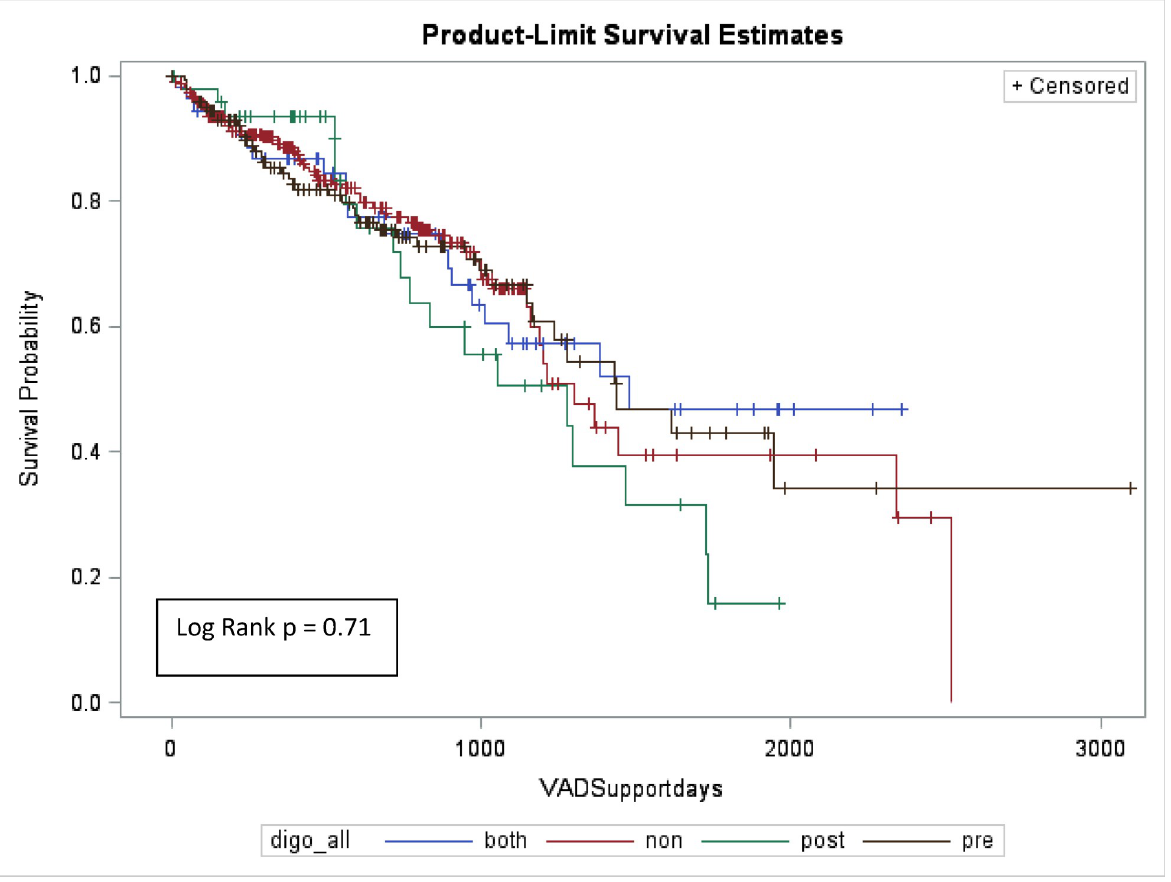
Fig 1. Kaplan Meier survival